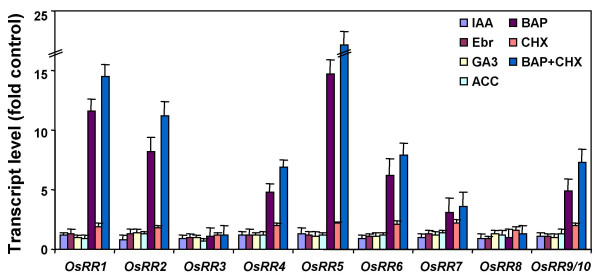
Expression profiles of the OsRR genes in response to different hormones and cycloheximide. The transcript levels of each OsRR gene in 6-day-old light-grown seedlings treated with IAA, Ebr, GA3, ACC, BAP, CHX and CHX+BAP for 3 h, were plotted as the relative expression (fold) of the seedlings mock-treated for the same duration.